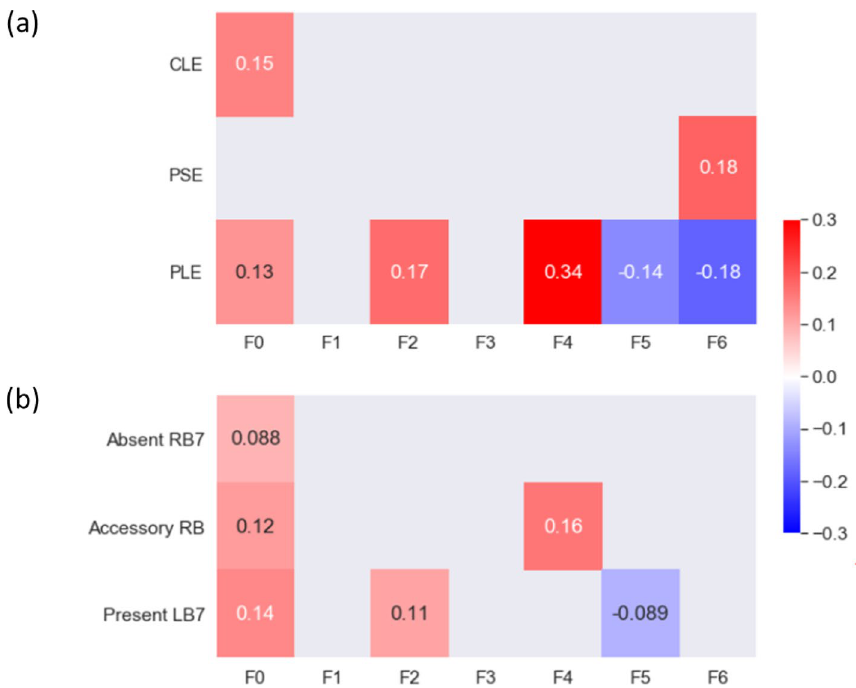
Figure 4. ( a ) The correlations between the factors and the emphysema subtypes. The subtypes are CLE, PLE, and PSE. ( b ) The correlations between the factors and the airway variants. The three variants are: (1) absence of a right medial-basal RB7 branch in RLL (Absent RB7), (2) presence of an accessory sub-superior RB branch in the RLL (Accessory RB), and (3) presence of an accessory LB7 branch in the LLL (Present LB7; see Figure E3). Only correlations with p value less than 0.05 are shown in the